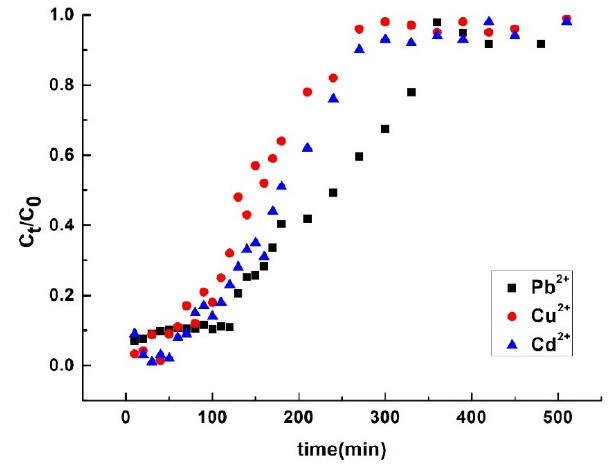
Figure 9. Adsorption curves of column experiments. Table 7. Thomas model parameters.